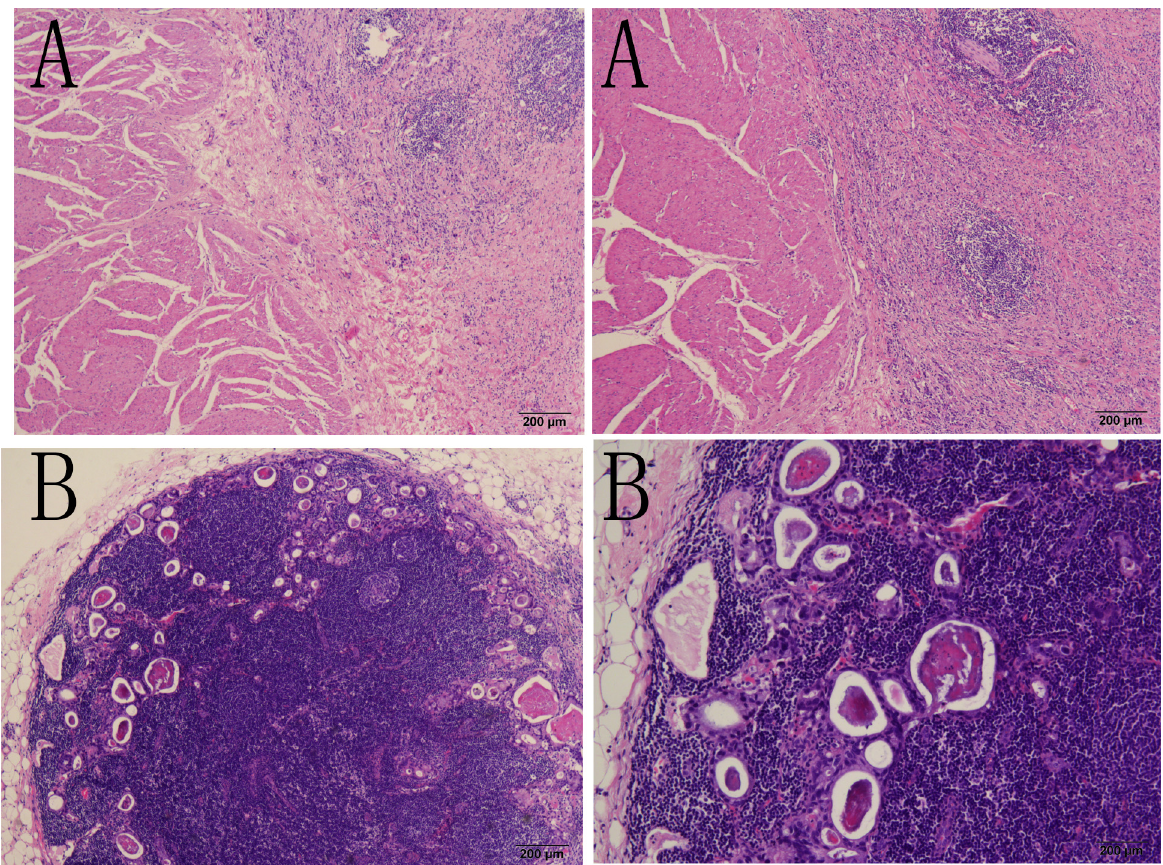
Fig 1. LNM occurred in an intra-mucosal gastric cancer patient shown in the H-E staining